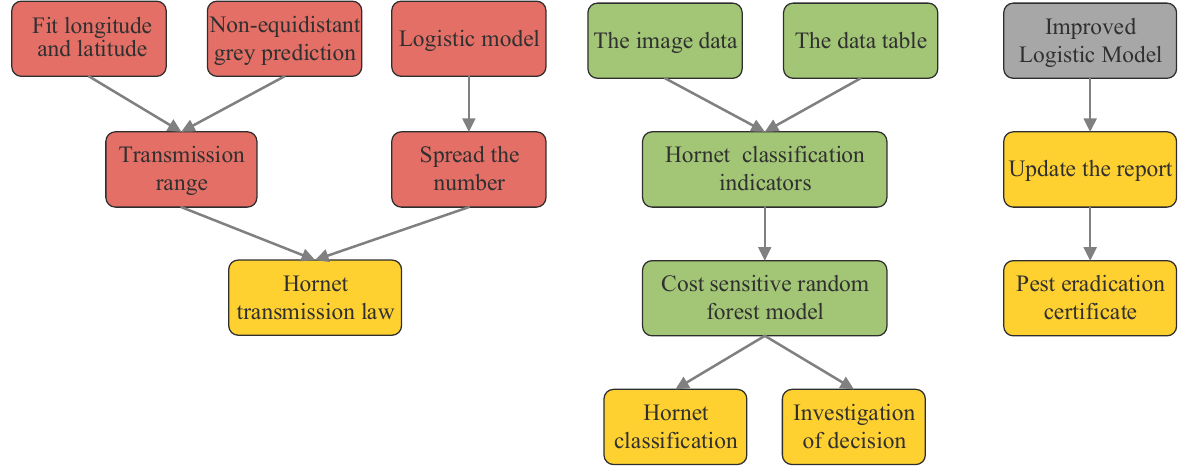
Figure 1. The scheme flow chart of the proposed method.